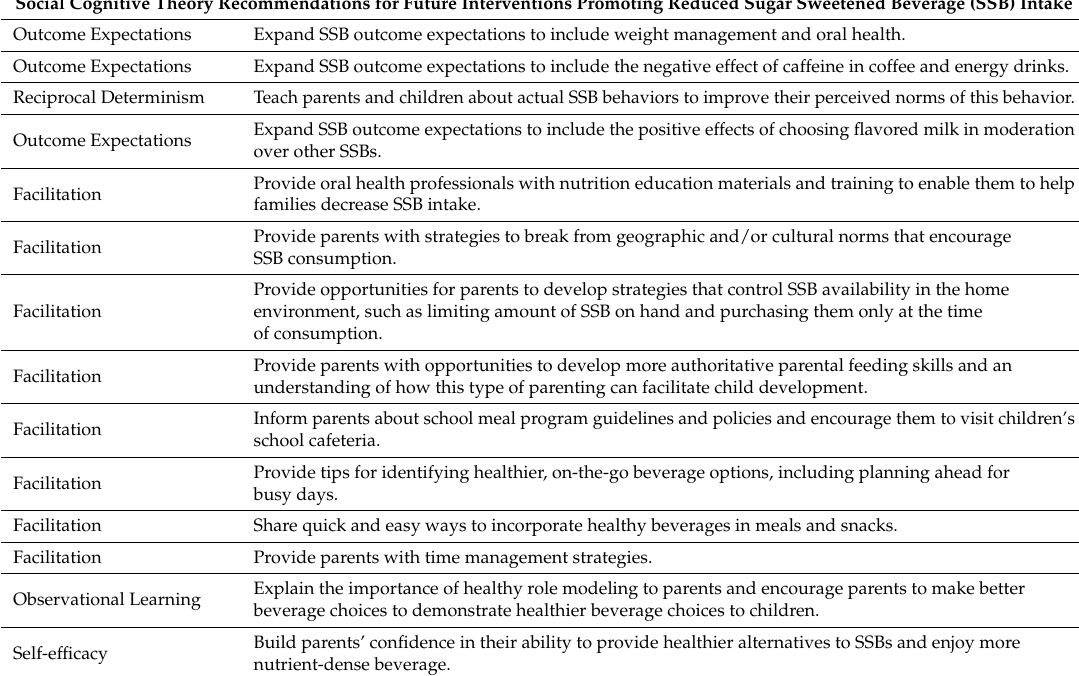
Table 1. Recommendations for Interventions Targeting Limiting Sugar-Sweetened Beverage Intake in Families with School-Age